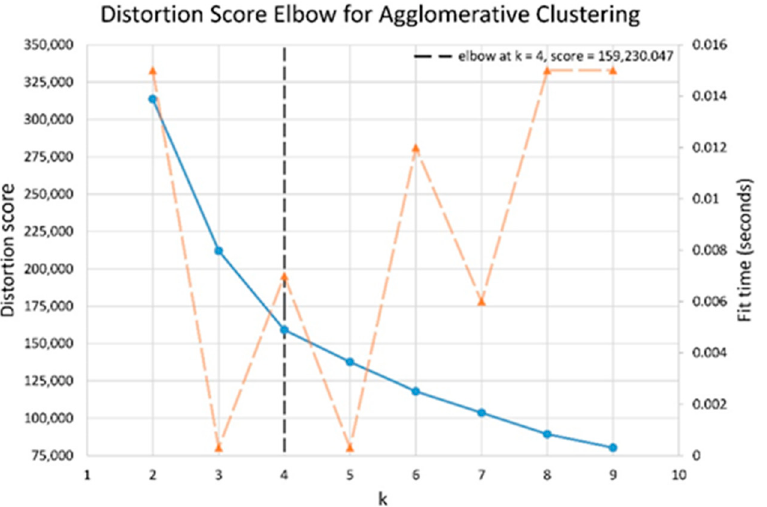
Figure 5. Elbow method results for Ward clustering algorithm (blue line indicates distortion score, and orange dashed line indicates the time to train the clustering model).